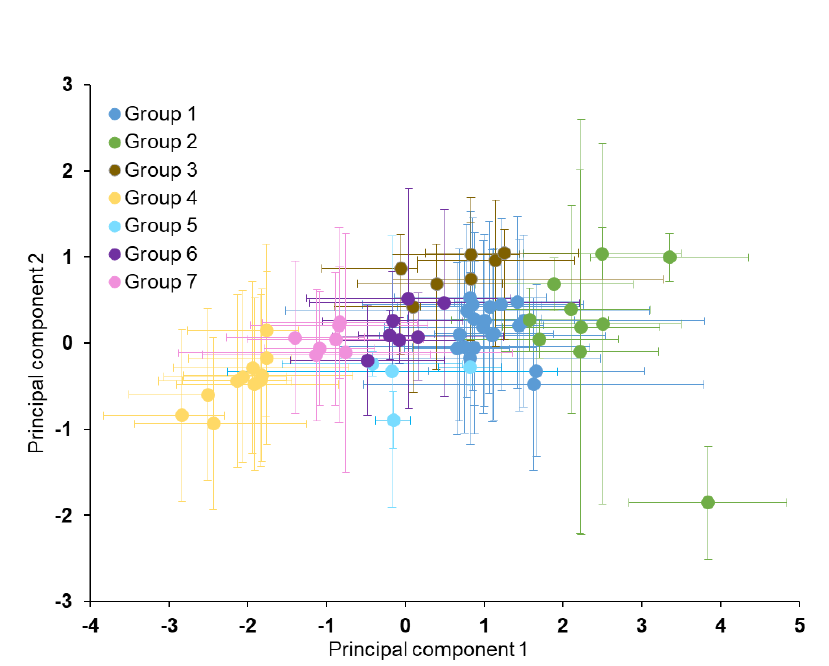
Figure 3. Mean value and standard deviation of MESO on first score plot from PCA performed at the regional scale.